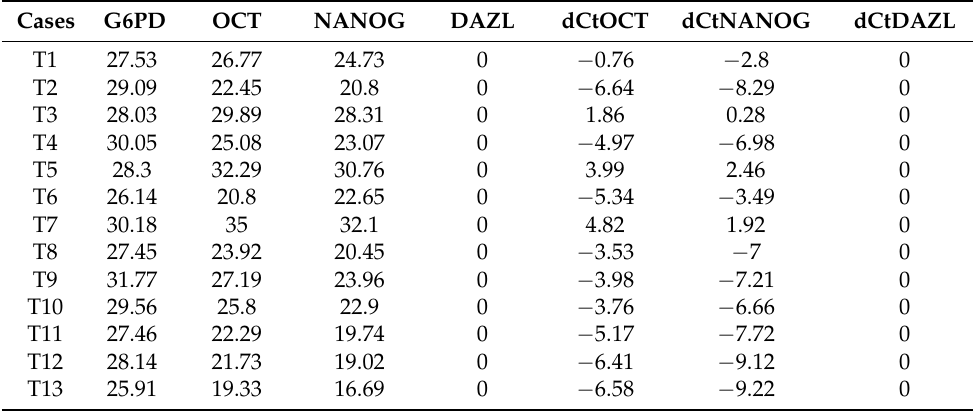
Table 3. Expression of G6PD, OCT, Nanog and DAZL in the selected